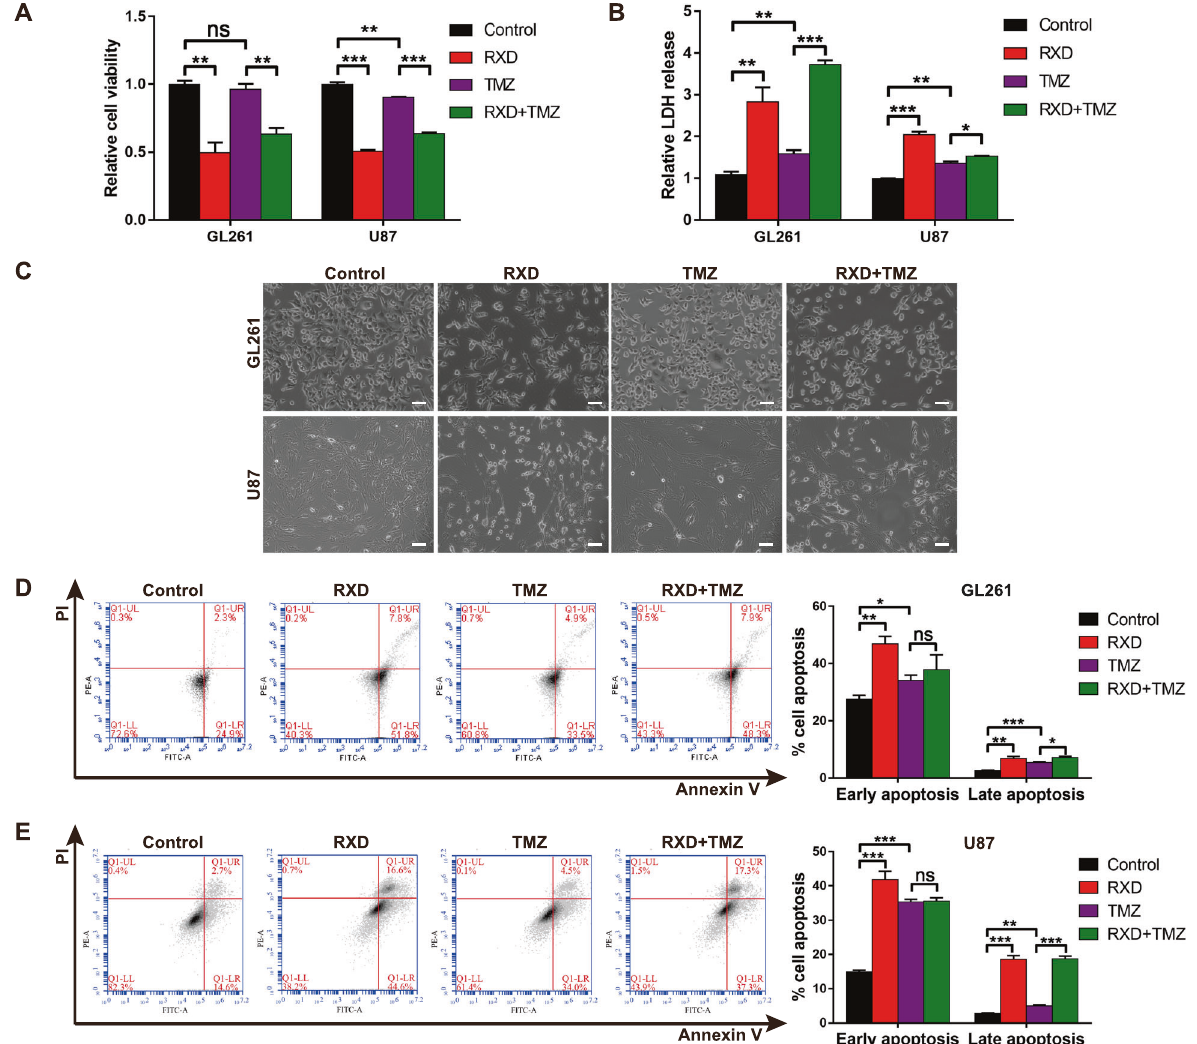
Fig. 1 Roxadustat inhibited GBM cell viability and induced chemoresistant GBM cell death. A Cell viability assay in GL261 and U87 cells treated with RXD (100 μ M towards U87, 200 μ M towards GL261) for 48 h and/or TMZ (200 μ M) for 48 h. B The LDH released in GL261 and U87 cells treated with RXD and/or TMZ for 72 h. C Representative images under the microscope of GL261 or U87 cells treated with RXD and/or TMZ for 48 h. Scale bar: 100 μ m. D and E Apoptosis analysis of GL261 or U87 cells treated with RXD and/or TMZ for 72 h. * P < 0.05, * *P < 0.01, *** P < 0.001, ns no signi fi cant